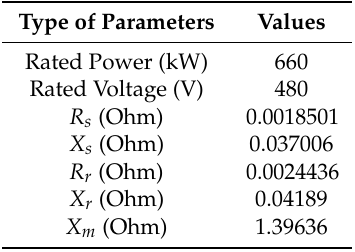
Table A3. Asynchronous generator parameters used in the 34 bus test